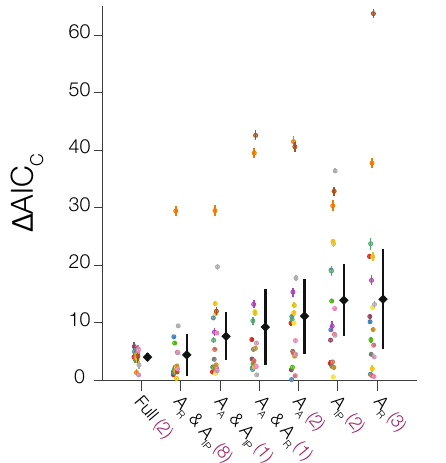
Figure 6. Bootstrapped model comparisons. Each black dot displays the mean ∆AIC c across observers with the error bar representing the 95% confidence interval. Each colored dot represents an individual subject’s ∆AIC c and the error bar represents the 95% confidence interval after bootstrapping. Model abbreviations: A R is maximum response gain, A IP is inflection point gain, and A A is additive shift modulation. The purple number next to the model is the number of subjects’ winning